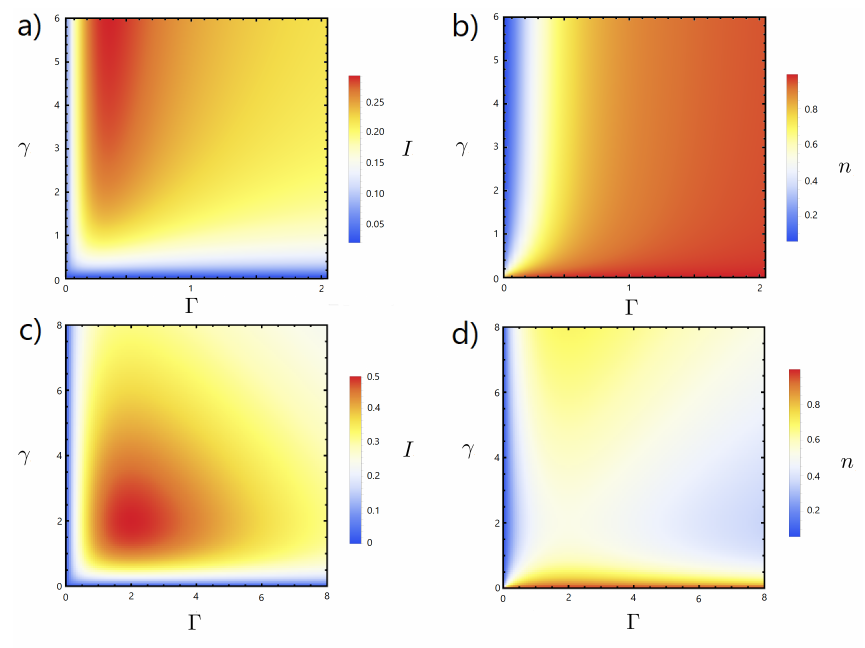
Figure 5: Total current across the junction (panel a) and mean occupation number (panel b) as a function of the incoming, Γ , and outgoing, γ , couplings for α = 0.5, γ = 0.1, t ( (cid:96) ) = 1. Panel c) and d) show the same quantities as in panel a) and b) C but for the fully quantum fermionic chain discussed in Ref. [ 61 ]